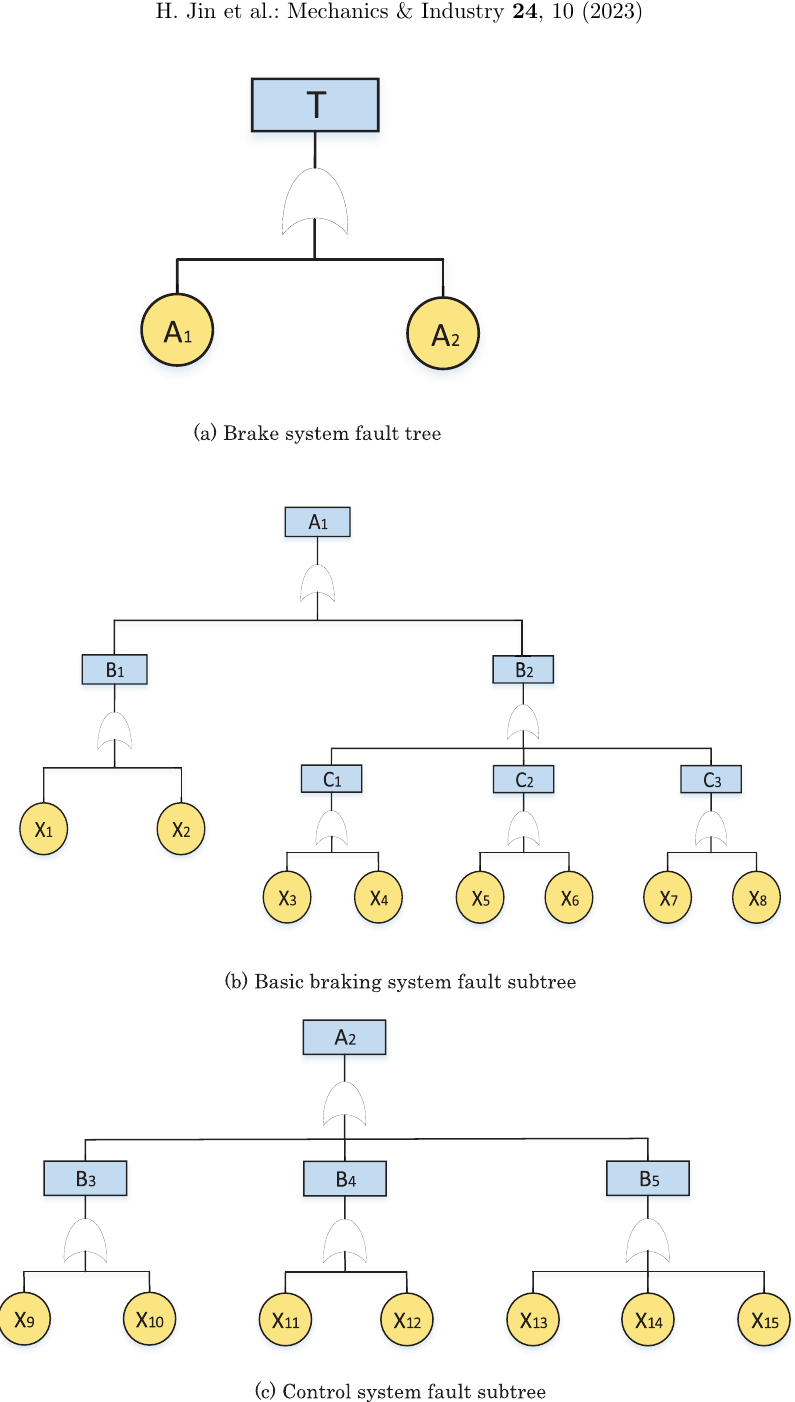
Fig. 5. Fault tree of electro-mechanical braking